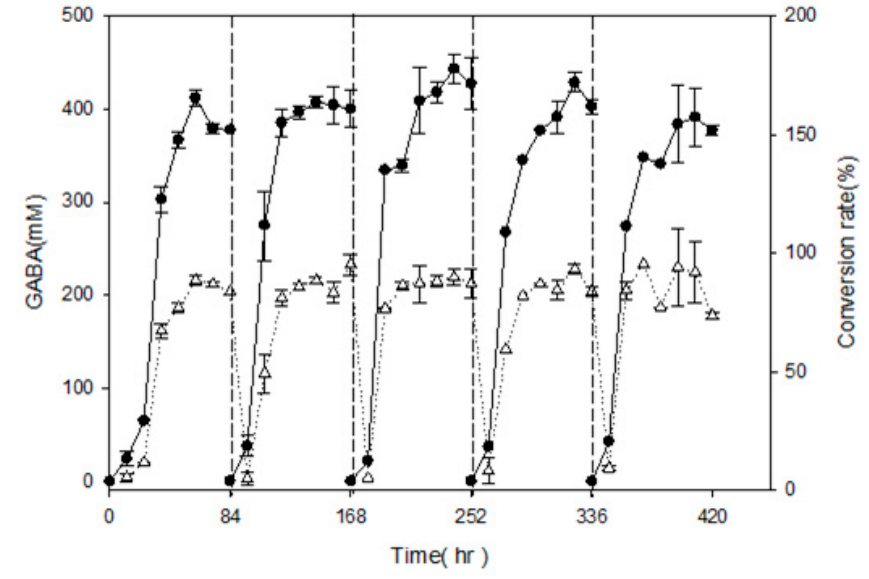
Figure 5. Effects of single hydrogel film adhesion on GABA production and conversion rate by L. brevis RK03 under semi-continuous fermentation, ( ● ) GABA; ( Δ ) Conversion rate. Conversion rate of GABA from MSG (%) = amount of GABA (mM)/amount of MSG added (mM). Every 84 h, the hydrogel film was moved to fresh MRS medium for the next cycle.